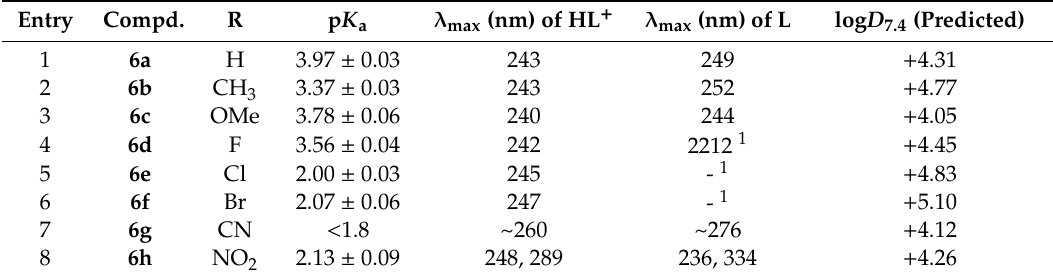
Table 2. Proton dissociation constants (pK a ) of the compounds determined by UV-visible titrations, λ max values (nm) of the ligand species in HL + and L forms and logD